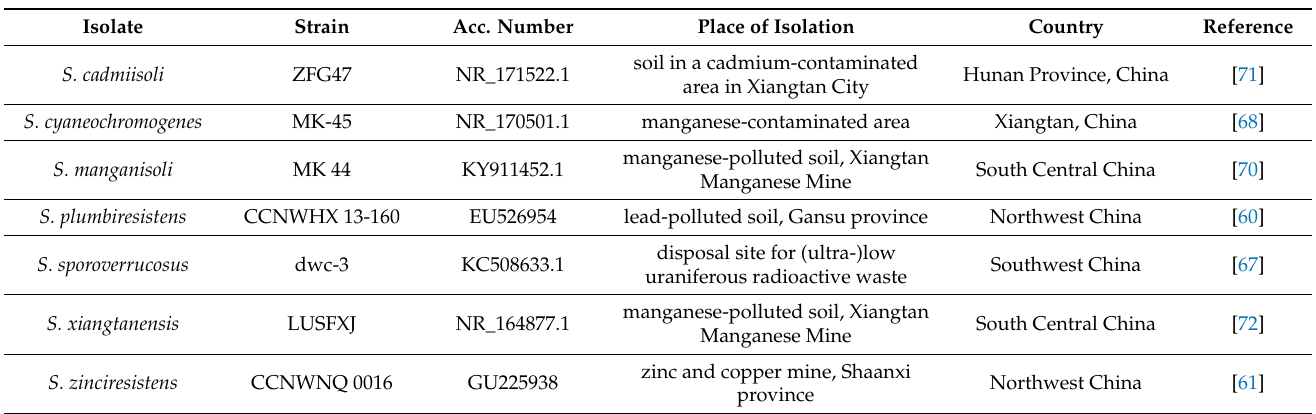
Table 3. Novel Streptomyces species isolated from heavy metal contaminated areas from reviewed literature. Isolate Strain Acc. Number Place of Isolation